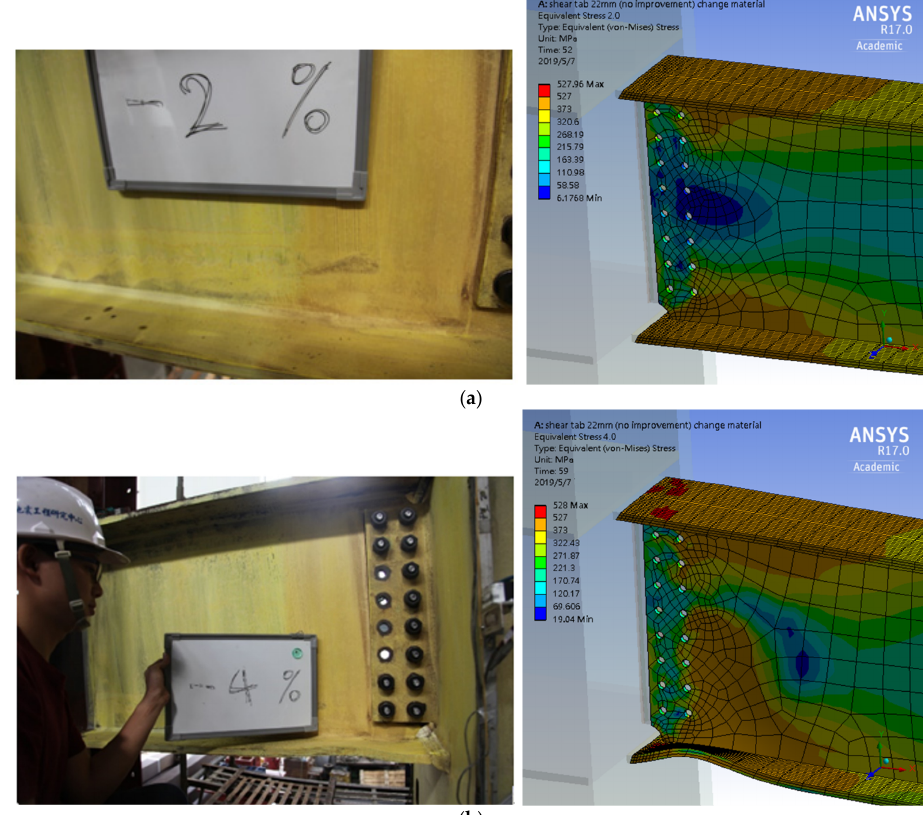
Figure 4. UR-connection behavior and von Mises stress distribution: ( a ) 2% drift , ( b ) 4%